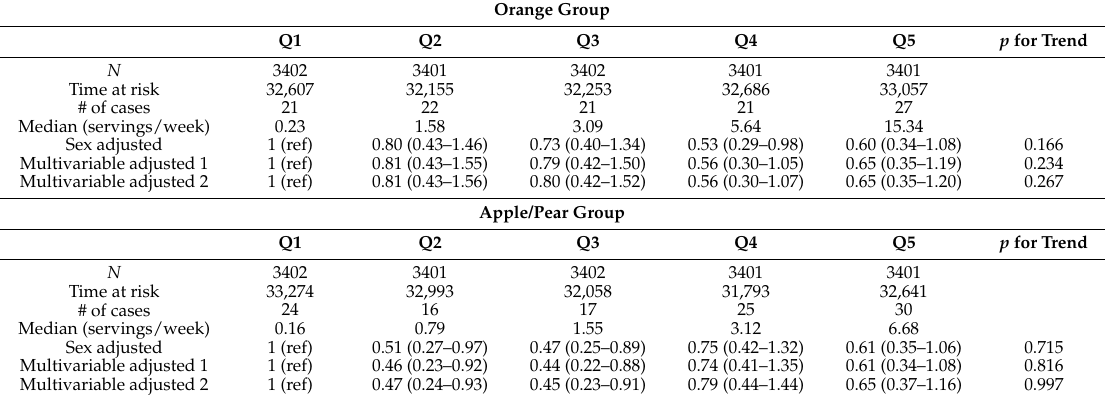
Table 4. Hazard ratios (HRs) of CVD according to baseline quintiles (Q) of specific groups of fruits and vegetables consumption. (HR and 95% confidence